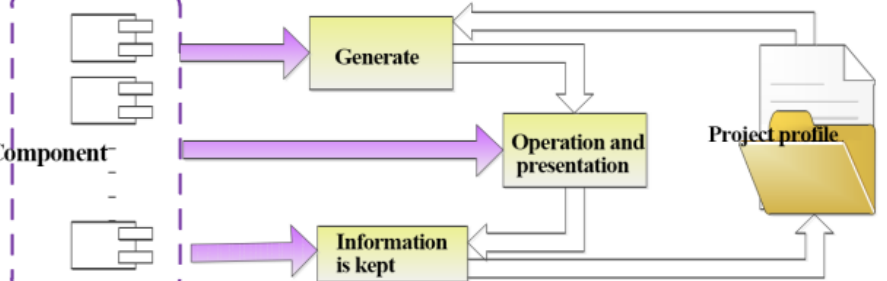
Figure 7. Configuration software schematic diagram.